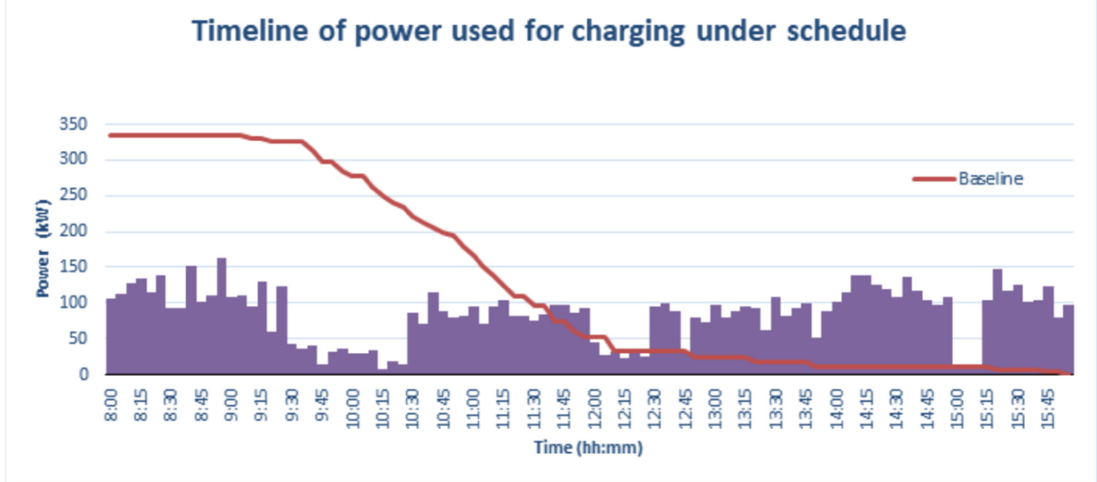
Figure 8. Scenario 3